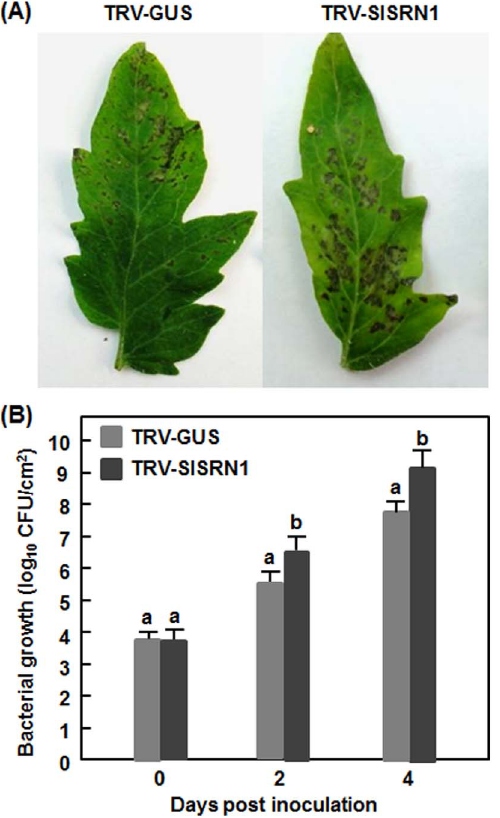
Figure 5. Silencing of SlSRN1 resulted in increased susceptibil- ity to P.syringae pv. tomato DC3000. Two-week-old seedlings were infiltrated with agrobacteria carrying TRV-SlSRN1 or TRV-GUS and were inoculated with Pst DC3000 two weeks after VIGS infiltration. Disease phenotype (A) and bacterial population (B) in leaves of TRV-SlSRN1- or TRV-GUS-infiltrated plants were recorded. Data presented are the means 6 SD from three independent experiments and different letters above the columns indicate significant differences at p , 0.05